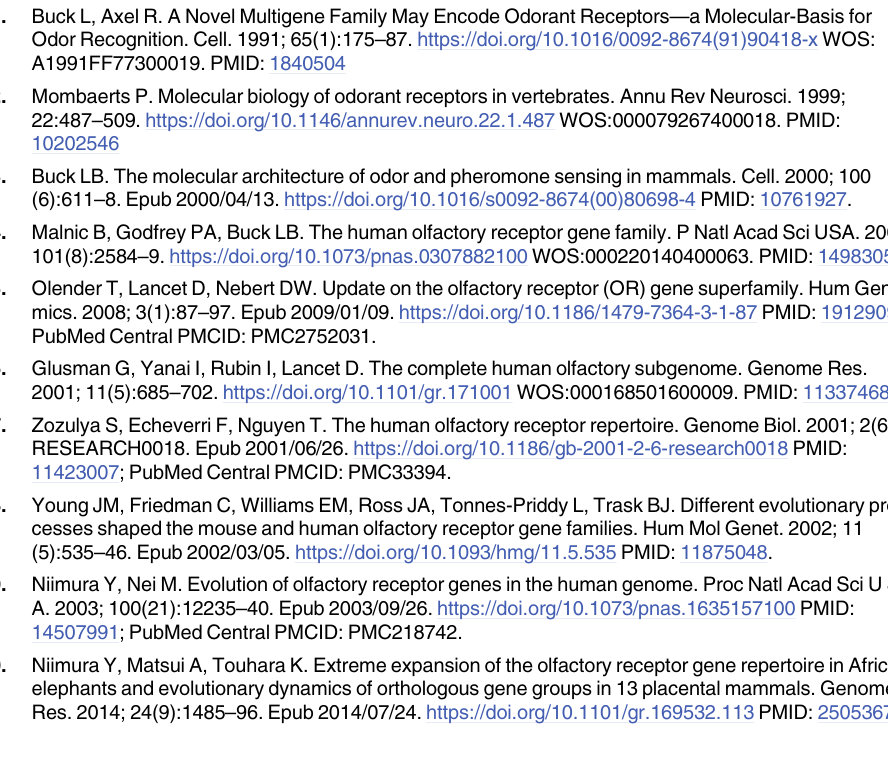
S3 Table. Collinear, tandem and proximal duplicate genes among the human functional OR genes. S4 Table. Enrichment of gene duplication modes for the human functional OR genes and each family. S5 Table. Version information on reference